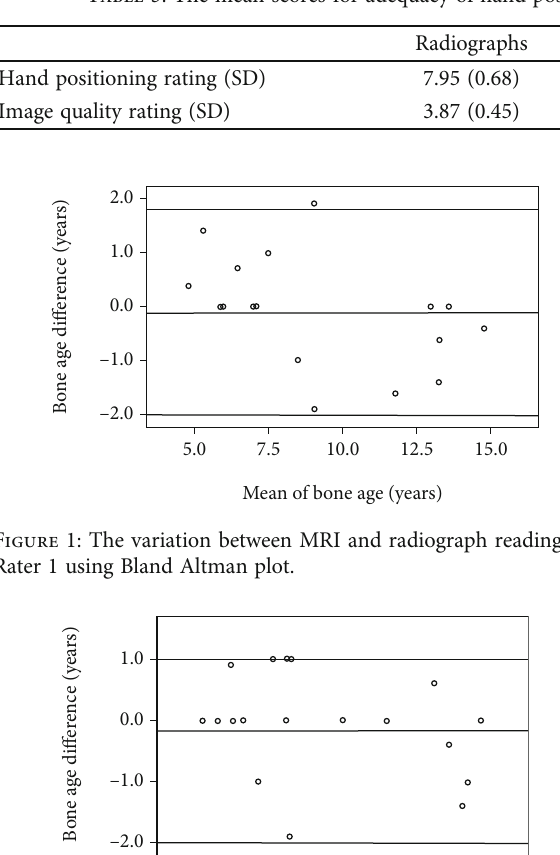
Table 3: The mean scores for adequacy of hand positioning as well as image quality for MRI scans and radiographs.